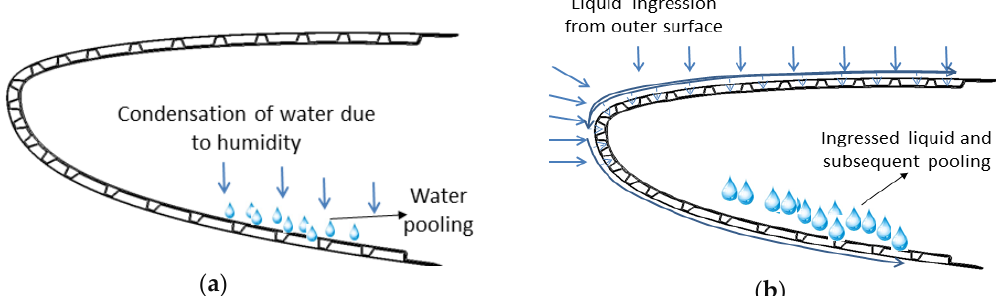
Figure 16. Leading edge (side view) showing liquid contamination inside the plenum due to ( a ) condensation or ( b ) water ingress.